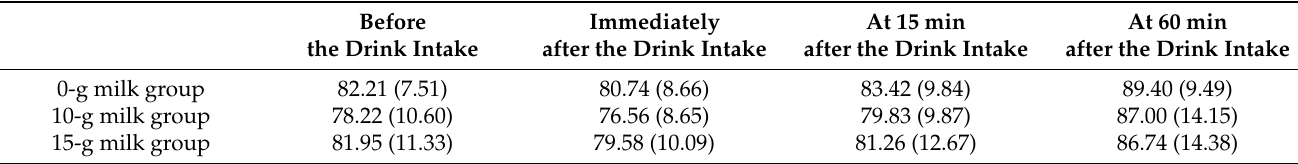
Table 3. Means of blood glucose levels (mg/dL) before and after drink